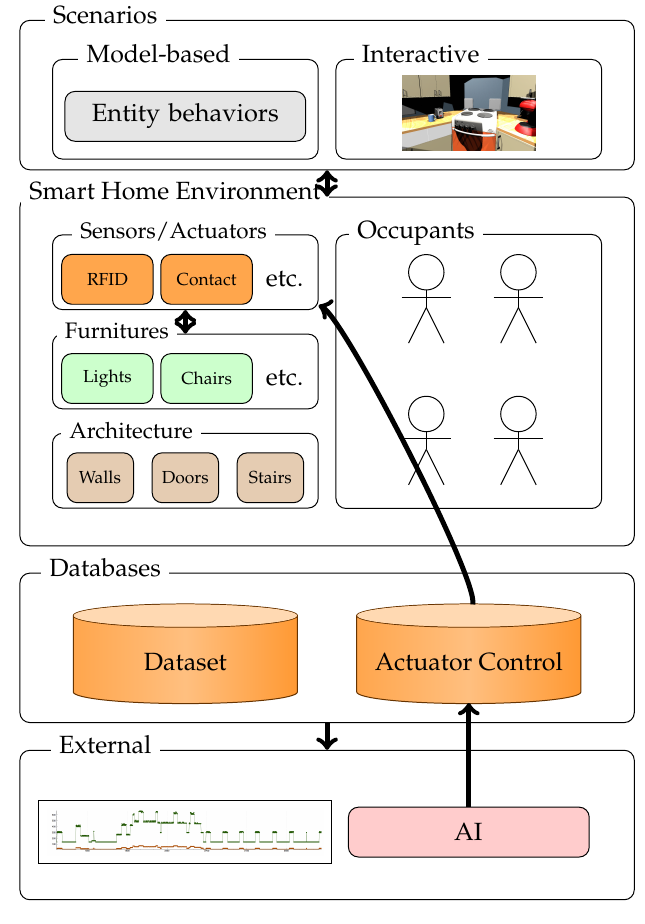
Figure 2. Overview of our proposition.